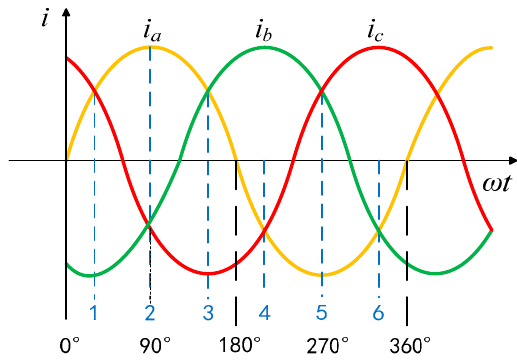
Figure 2. Three-phase winding supply current waveform.